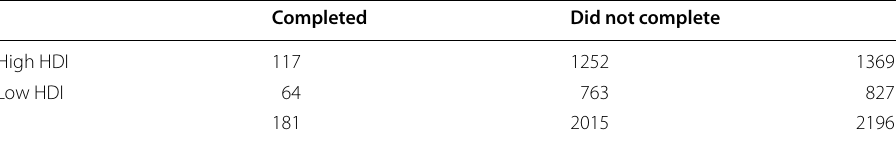
Table 3 Contingency table of “Structural materials: selection and economics”, third trimester, 2017, successful completion by